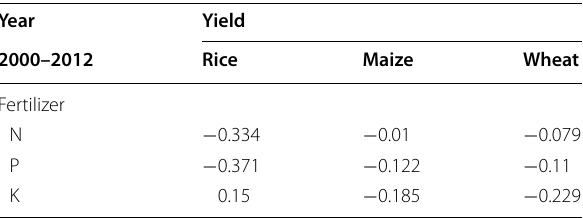
Table 3 Correlation between area under cultivation of rice, maize and wheat and their respective yields